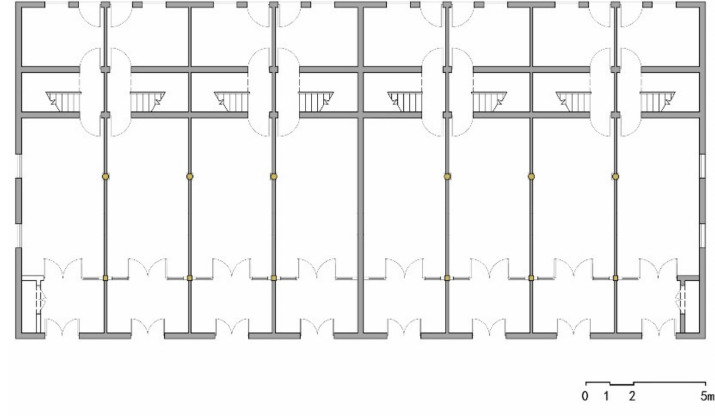
Figure 12. The first floor plan of the No. 1 Building of “Tianbaoli”.